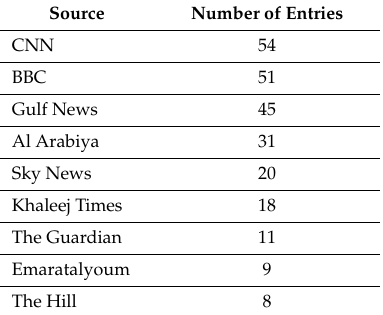
Table 1. Most frequently used